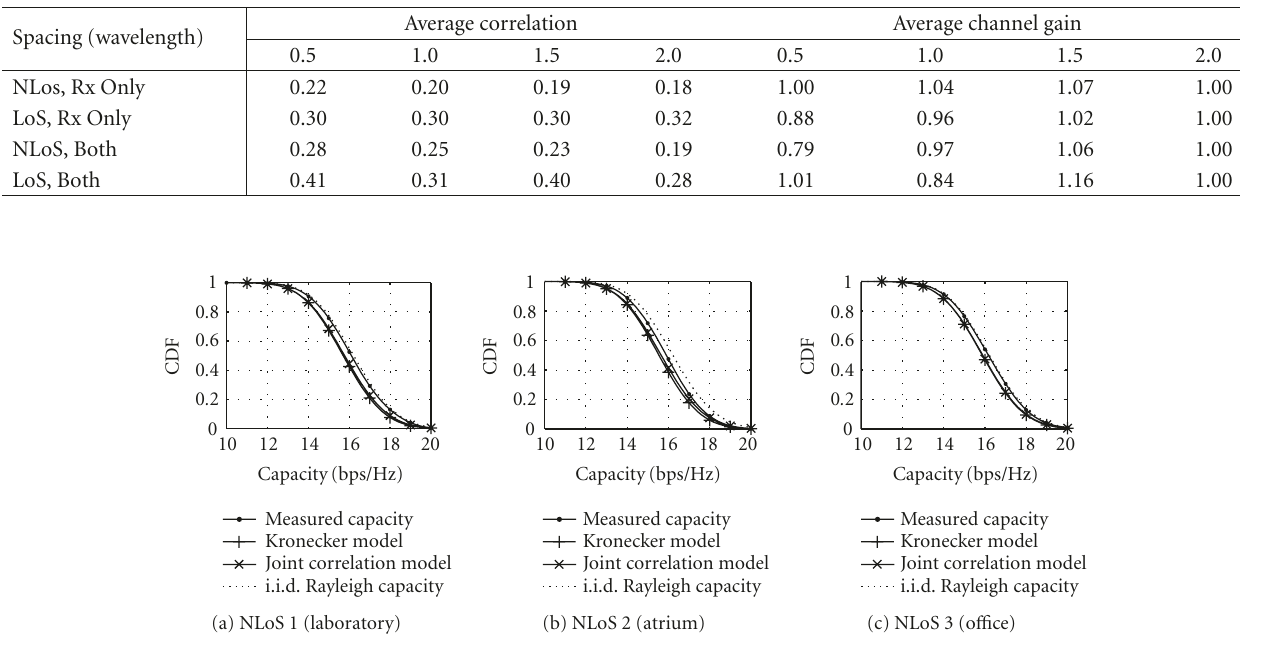
Table 2: MIMO channel parameters for di ff erent antenna spacings.